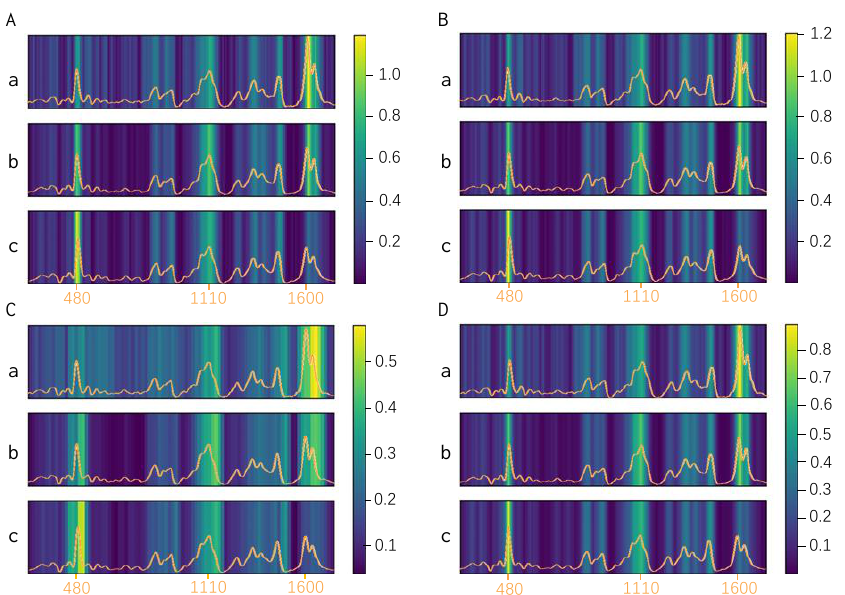
Figure 6. Feature maps of four parallel convolution layers ( A – D ), healthy wheat kernels ( a ); mildly infected wheat kernels ( b ); severely infected wheat kernels ( c ). The insets are the spectra of the corresponding types of kernels, and orange colored X-coordinates represent the Raman shift (cm − 1 ).